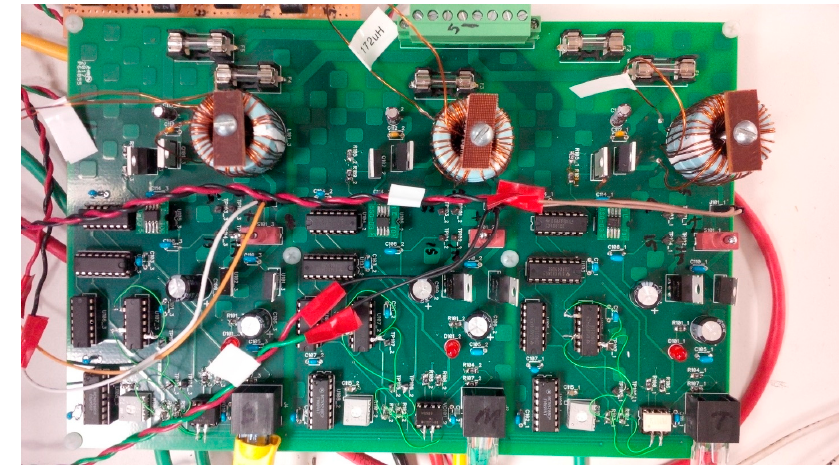
Figure 7. AEQ control board with 3 AEQ units.